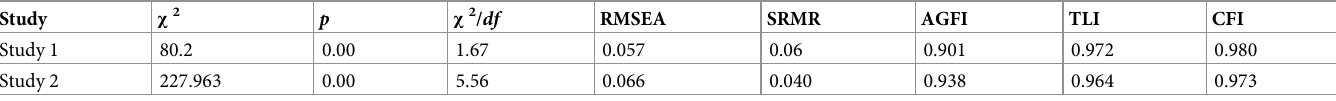
Table 8. Goodness of fit indices of the two weight efficacy Life-Style questionnaire versions used in study 1 and study